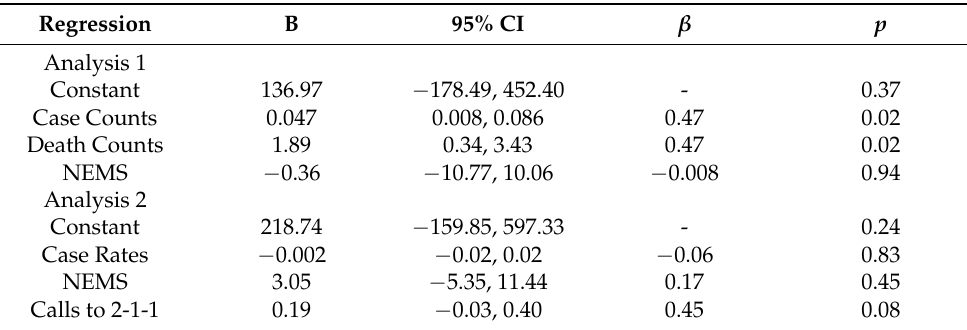
Table 2. Results of regression